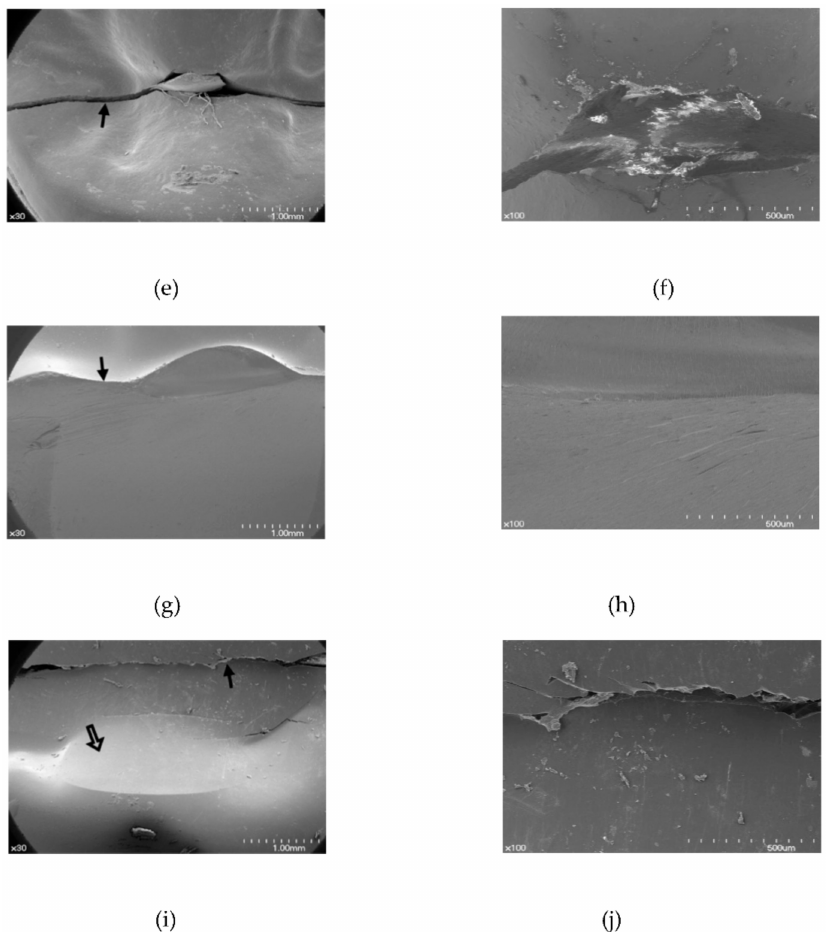
Figure 7. Scanning electron microscopy images after the indirect tensile test (occlusal